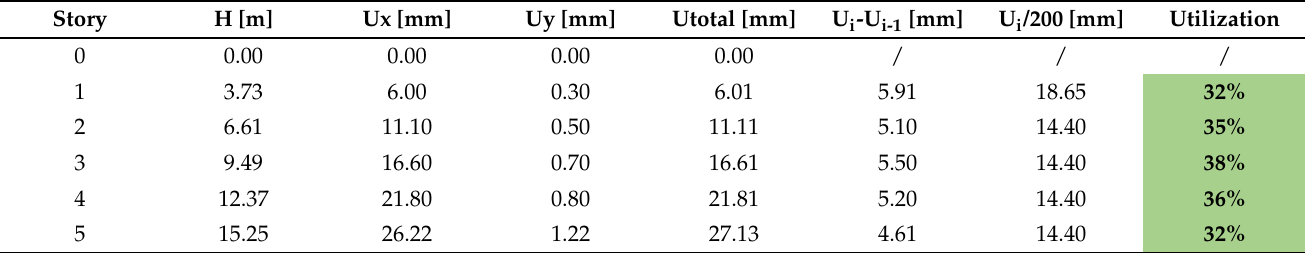
Table 6. Validation of inter-story drift (EN 1998)—presented only for Section B.